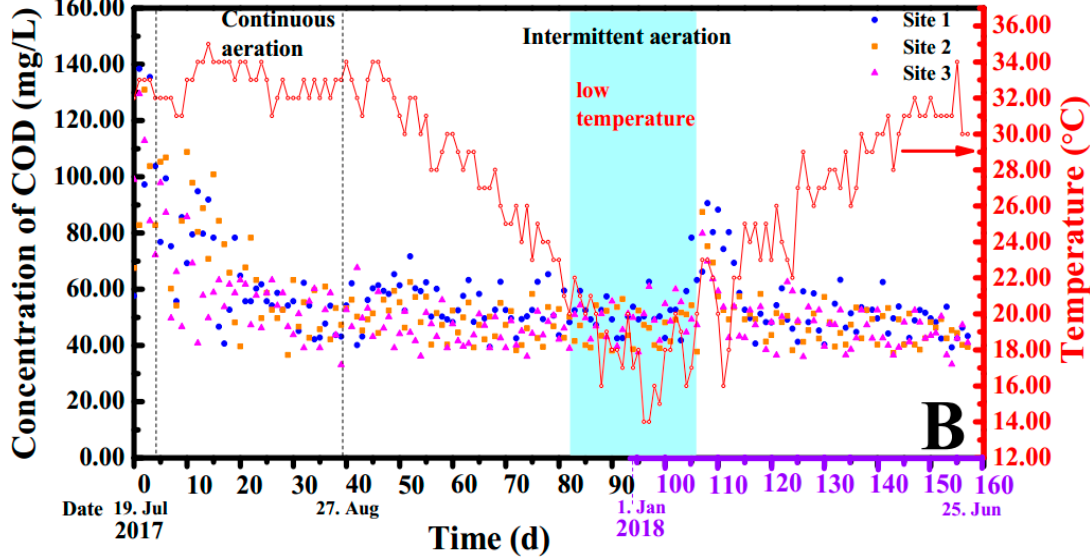
Figure 3. The NH 4+ -N and COD improvement of river ( A : NH 4+ -N, B : COD).